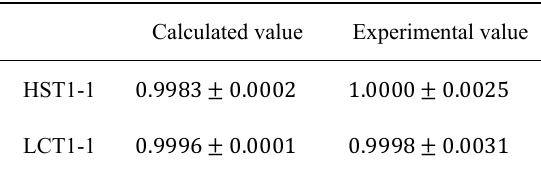
Table 2. The calculated and experimental values before the cross-section adjustment